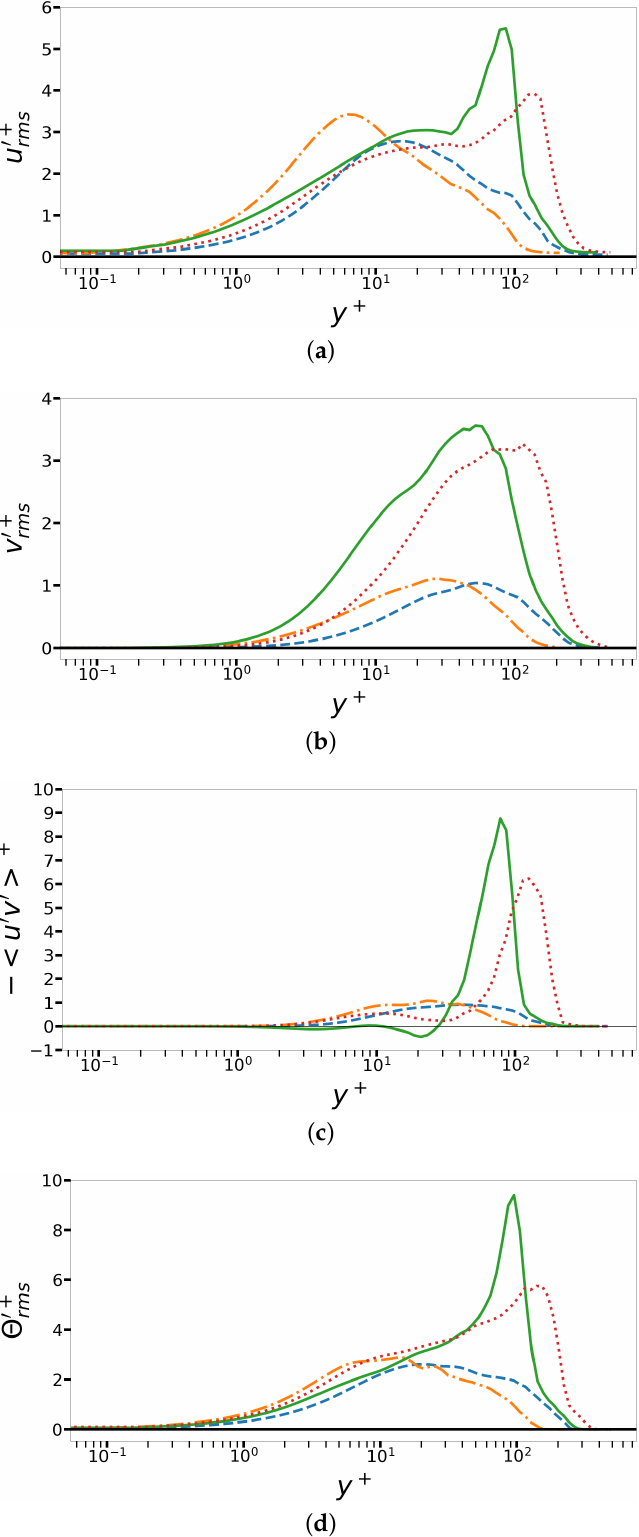
Figure 14. CASE 1: ( a ) RMS of streamwise velocity fluctuations, ( b ) RMS of wall-normal velocity fluctuations, ( c ) shear Reynolds stresses, and ( d ) RMS of thermal fluctuations (profiles as in the legend of Figure